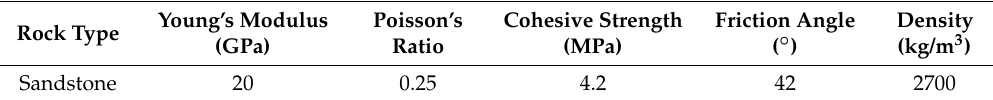
Table 2. Input parameters used in FLAC 3D analysis.